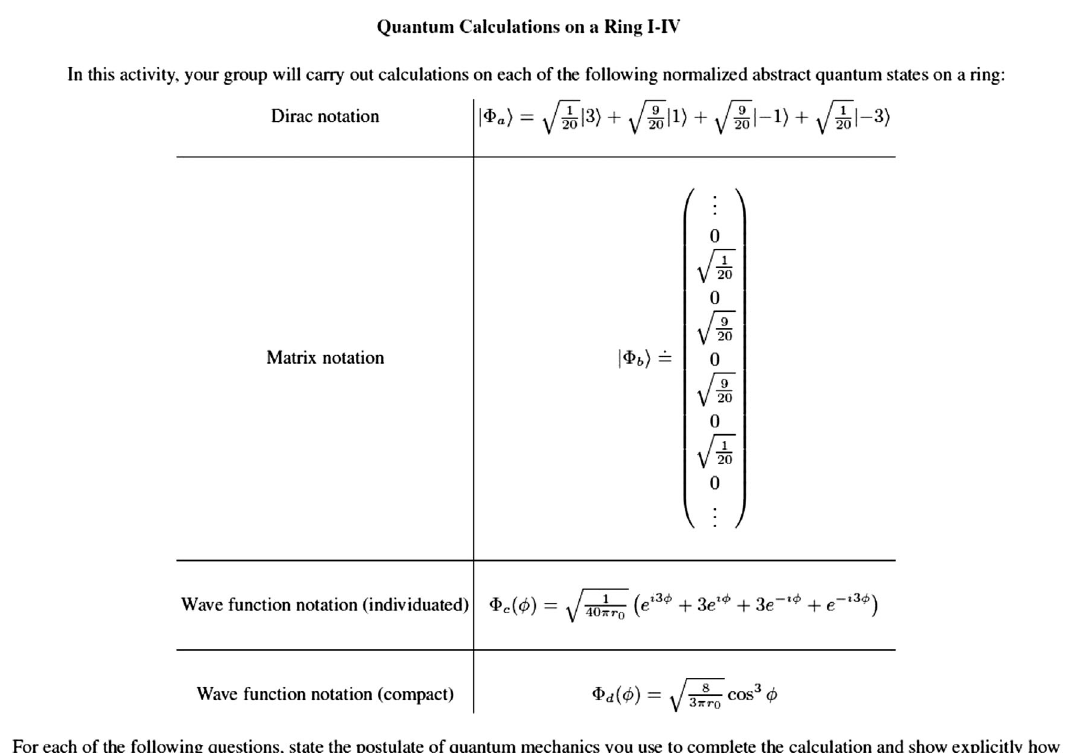
FIG. 3. The Paradigms activity angular momentum and energy for a particle on a ring. The activity involves four different representations of the given quantum state (above) and asks the same set of questions for each state (below). (Note that I ¼ Mr 2 0 is the moment of inertia for the particle on the